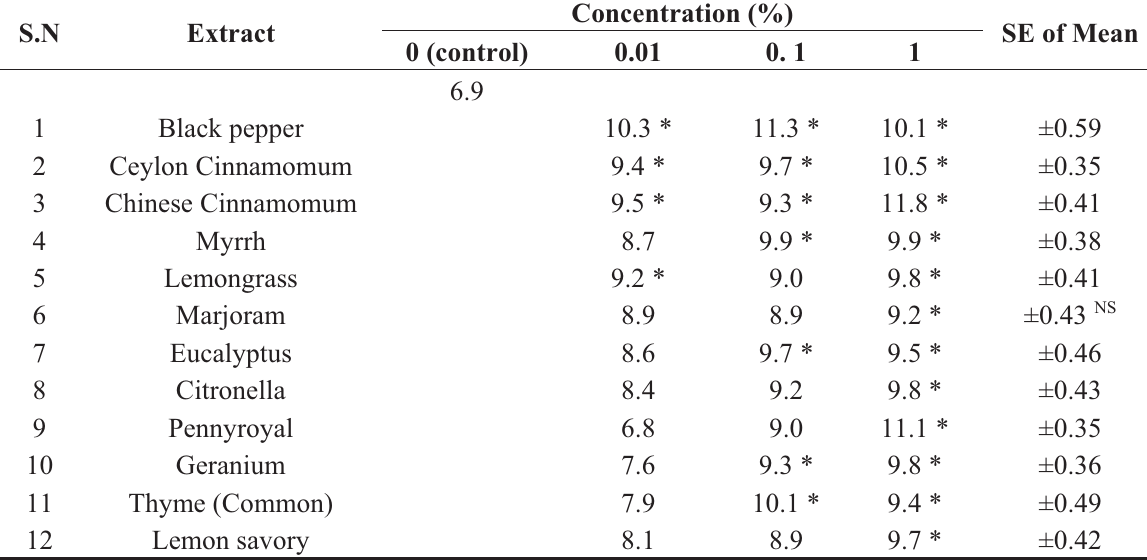
Table 2. Response of female Megalurothrips sjostedti to the repellent effect of 24 plant extracts at three concentrations (0.01%, 0.1% and 1%) of extract solution and control on filter paper.